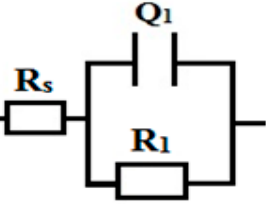
Figure 5. One-time constant model used to fit the experimental data of the bare alloy. Table 1. The impedance parameters of bare and coated Ti alloy in artificial saliva solution of pH 7.4 at 37 °C.